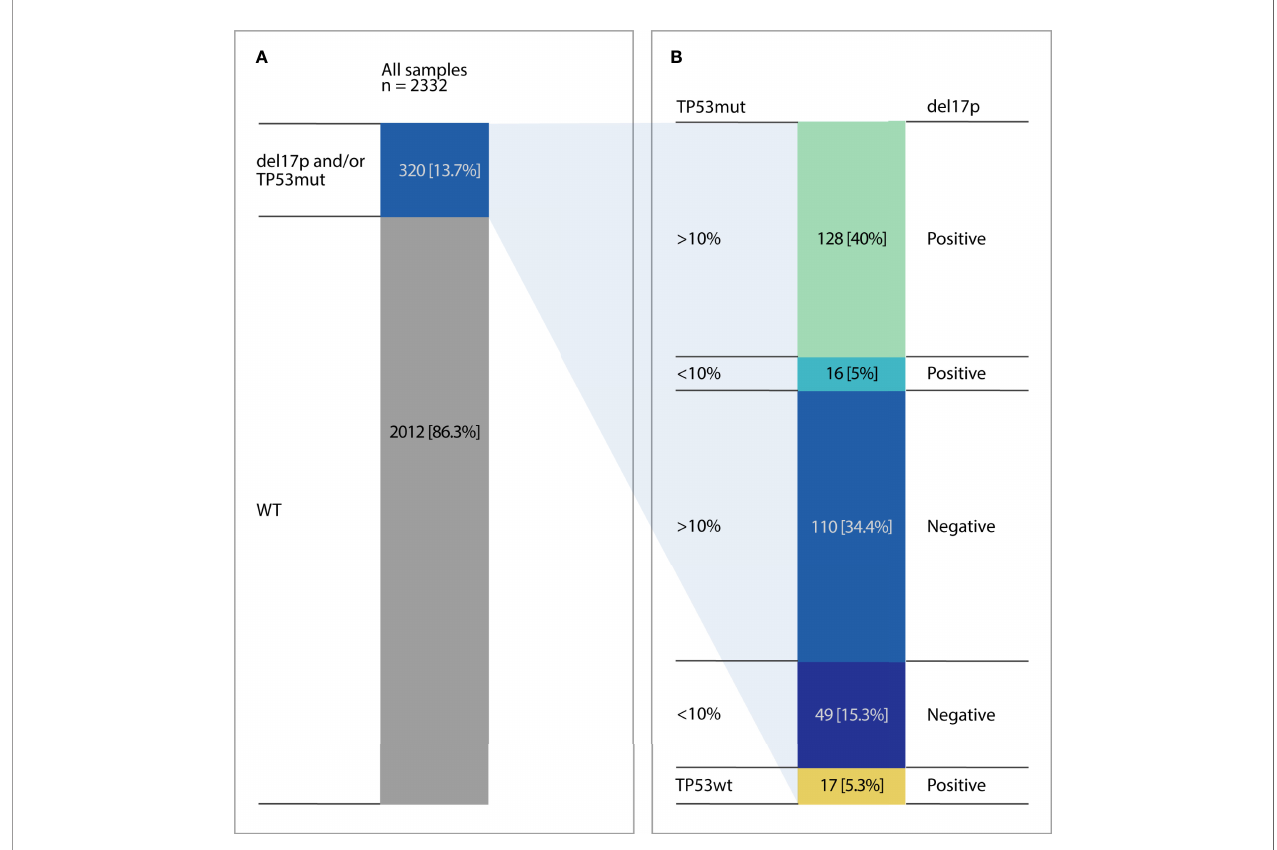
FIGURE 1 | TP53 aberrations in the analyzed cohort. Composition of TP53 defects.